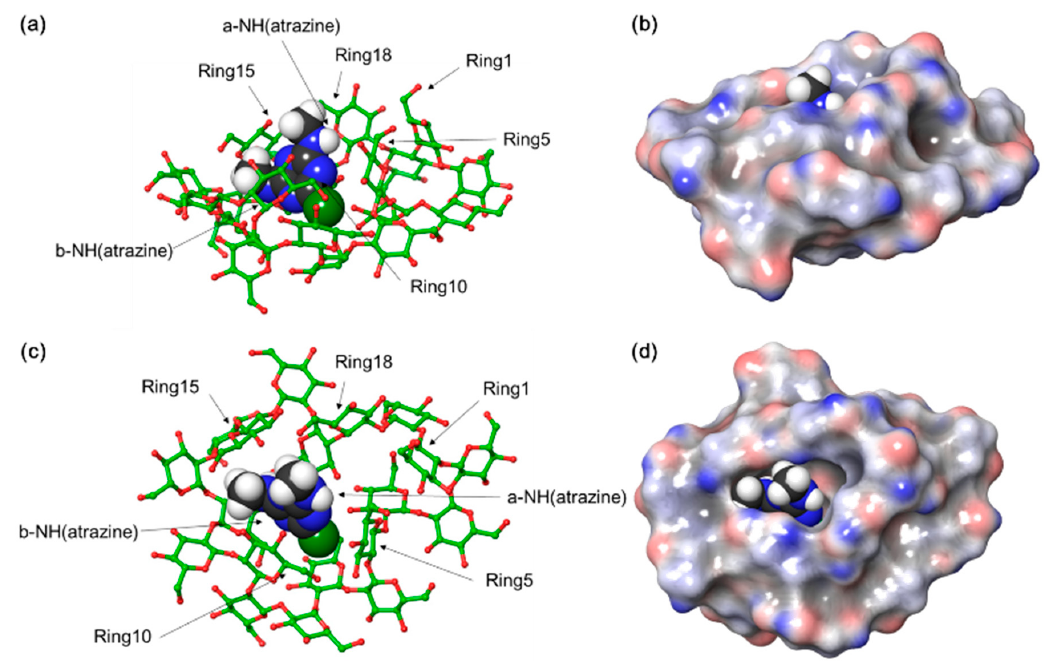
Figure 9. The highest-scoring docked pose of Cys and atrazine from molecular docking simulation: ( a ) side-view; ( b ) side-view with molecular surface area of Cys; ( c ) top-view; ( d ) top-view with molecular surface area of Cys. The carbon atoms of Cys were colored green, and atrazine was rendered by gray. Atrazine was represented by a space-filling model. For clarity, all hydrogen atoms of Cys were omitted.